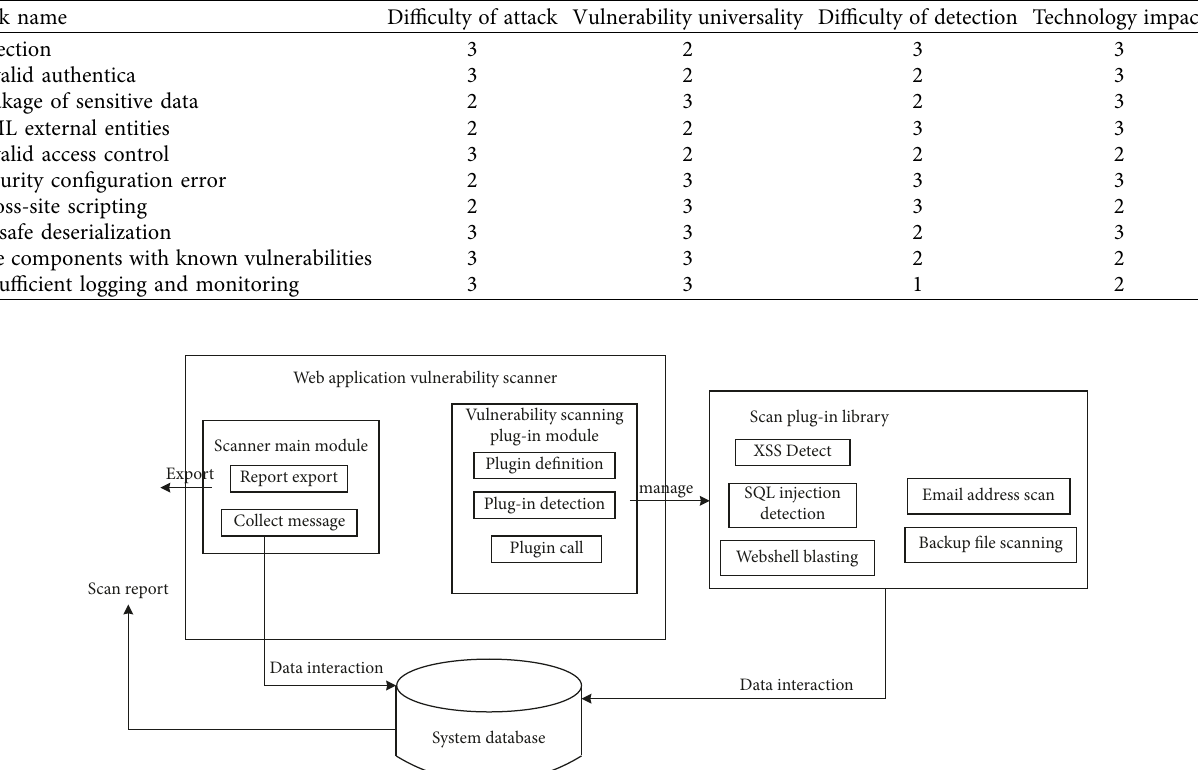
Table 1: Web application security risks.